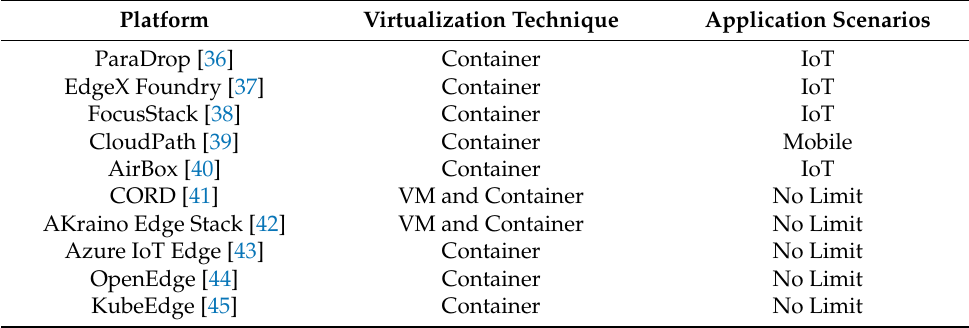
Table 2. Illustration of Container used in edge computing